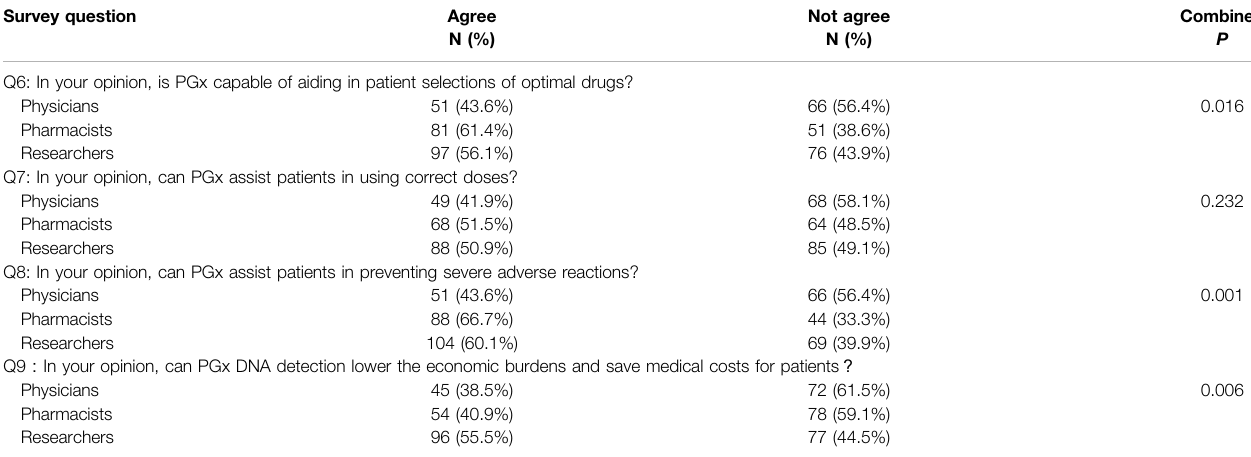
TABLE 2 | Awareness of PGx ( χ 2